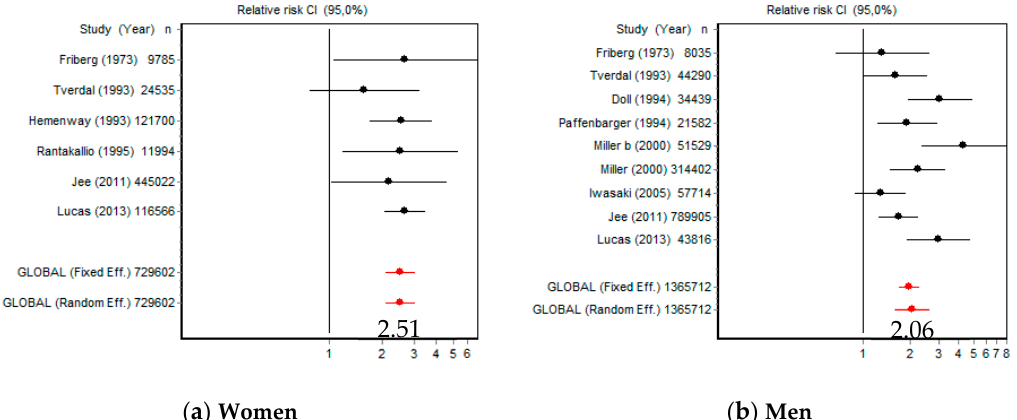
Figure 3. Forest plots of reported suicide rates in female and male smokers.